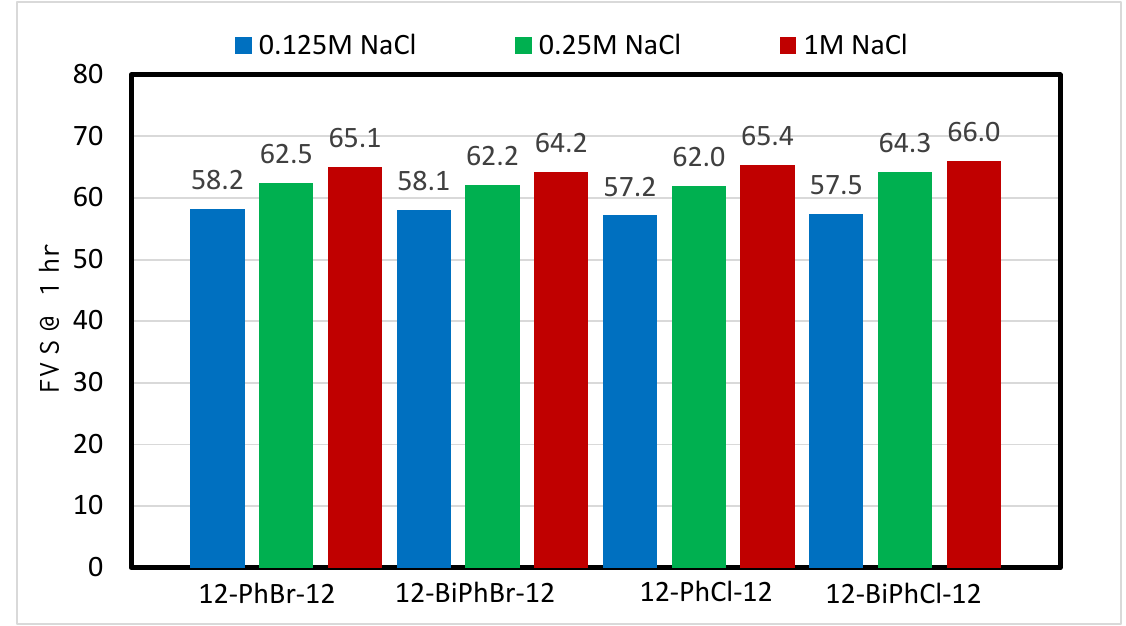
Figure 6. Effect of salinity on foam volume stability of different surfactants. Figure 6. E ff ect of salinity on foam volume stability of di ff erent